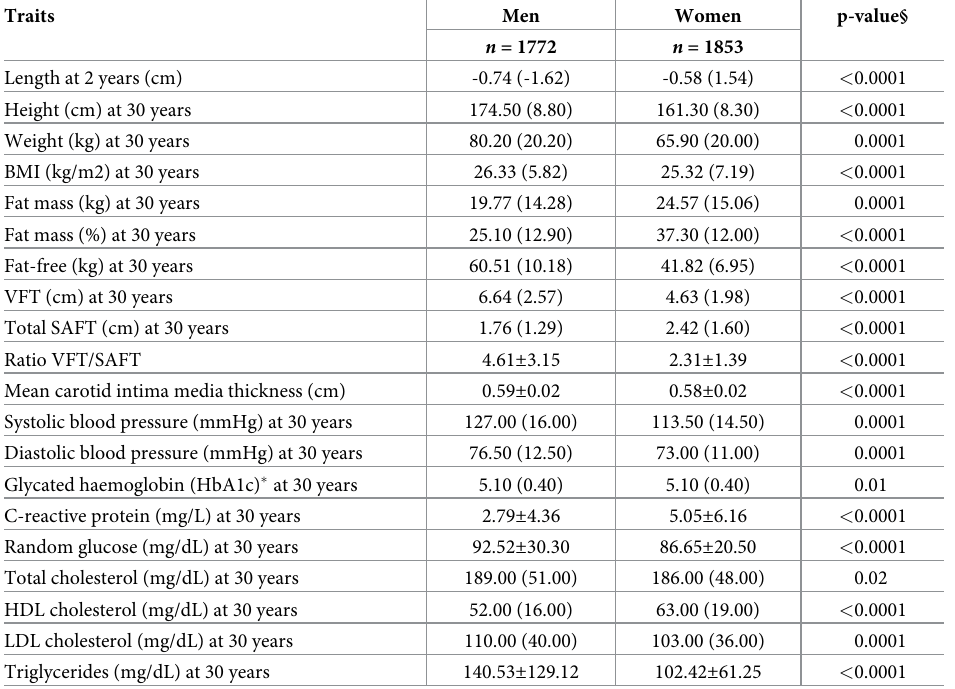
Table 1. Characteristics of the study sample.